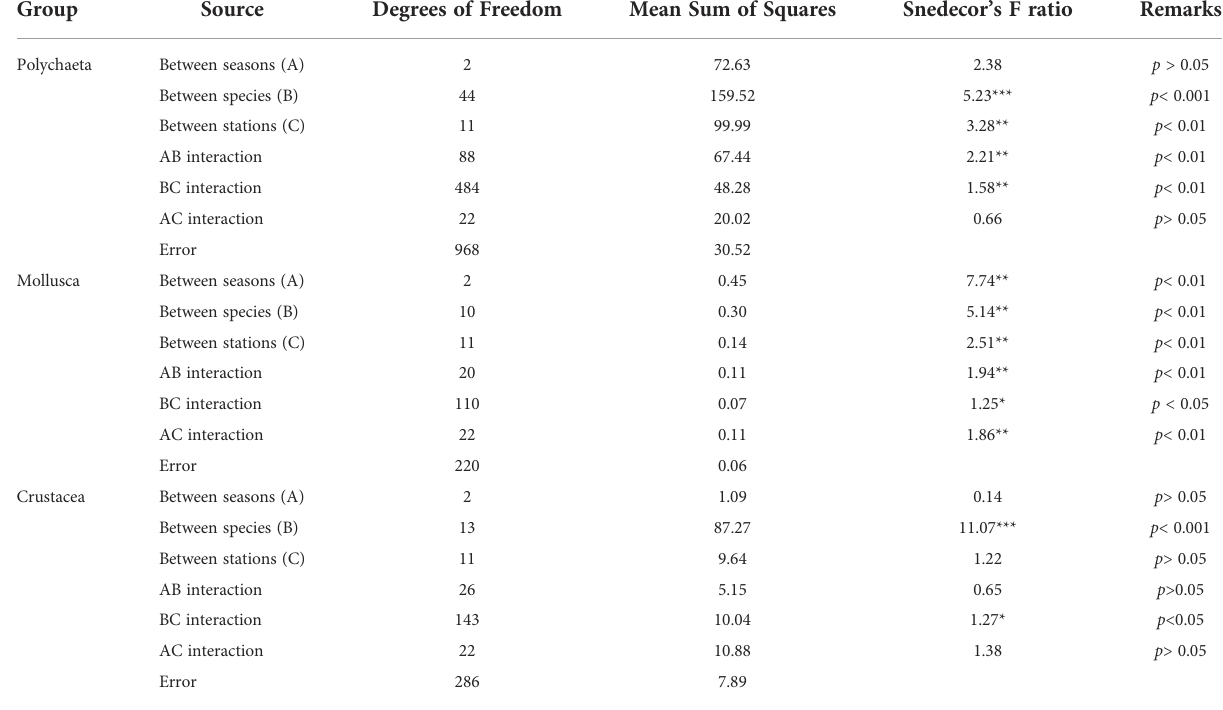
TABLE 3 Result of three-way ANOVA of macrobenthic faunal abundance data (Polychaeta, Mollusca, and Crustacea): Comparing the signi fi cance of seasonal, species, station differences, and their interaction effects (* p < 0.05, ** p < 0.01, *** p < 0.001). Group Source Degrees of Freedom Mean Sum of Squares Snedecor ’ s F